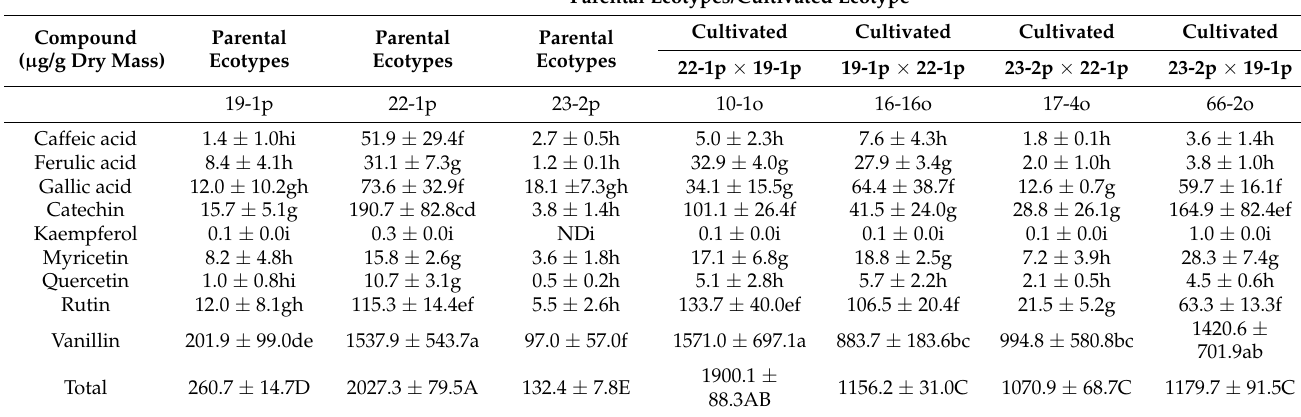
Table 2. Content of phenolic compounds found in Ugni molinae leaves in relation to domestication degree. Lowercase letters indicate significant differences of compound and uppercase letters indicate significant differences of total concentration according to ANOVA and Tukey’s test ( p ≤